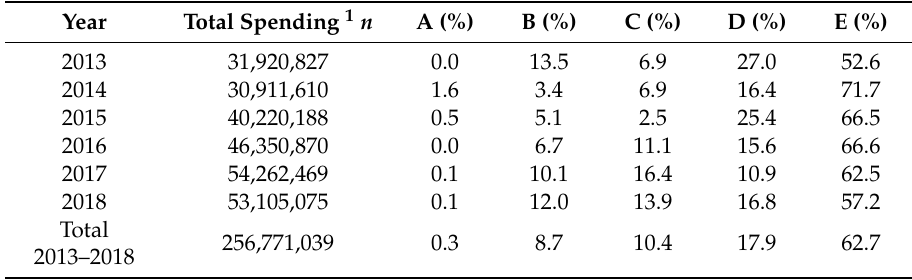
Table 1. Nutri-score classification of the advertising spending by the 10 top companies in soft drinks (SDs) and sugar-sweetened beverages (SSBs) in Spain by